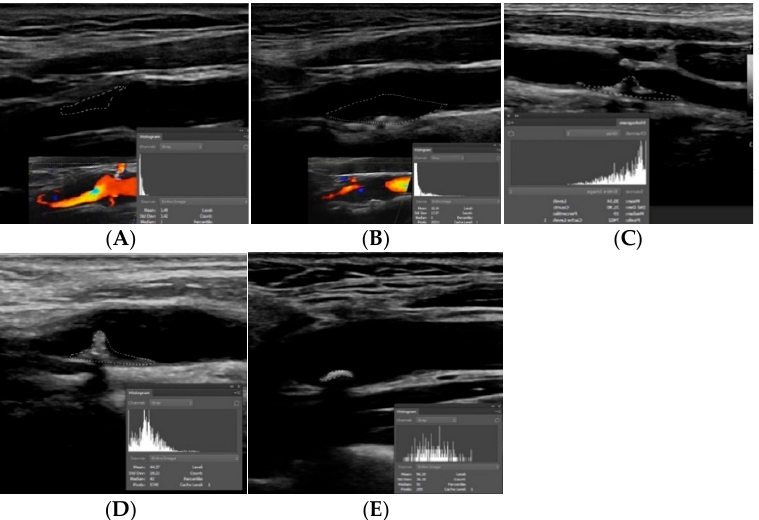
Figure 2. Subjective and objective assessment of carotid plaque echogenicity. Type 1 ( A ) refers to a uniformly echolucent plaque. Type 2 ( B ) is a plaque mainly echolucent with small areas of echogenicity. Type 3 ( C ) is predominantly echogenic with small areas of echolucency. Type 4 ( D ) is a uniformly echogenic plaque. Type 5 ( E ) is a plaque that cannot be otherwise classified owing to heavy calcification and acoustic shadow. Images presented are B-mode scans. In A and B colour Doppler was also used to delineate the plaques. Embedded panels at the right down corner represent Gray Scale Median (GSM) histograms. Notice that in type 1 and 2 plaques the histogram is heavily skewed to the left (lower GSM values, closer to total black) whereas in type 3 and 4 plaques GSM values are more evenly distributed or even skewed to the right (higher GSM values, closer to total white).